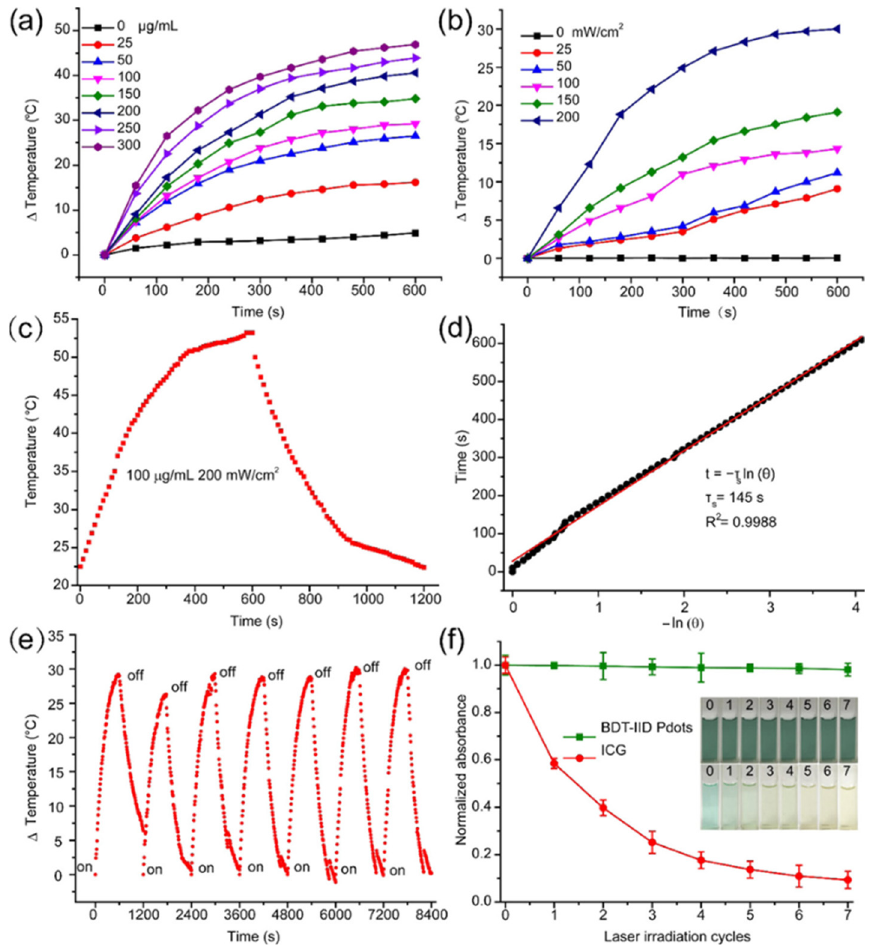
Figure 4. PTT characteristics of BDT-IID Pdots. PTT heating curves of the BDT-IID Pdots ( a ) with different concentrations upon 200 mW/cm 2 laser exposure at 660 nm and ( b ) with different laser power densities at 100 μ g/mL. ( c ) Photothermal effect of the BDT-IID Pdots dispersions under laser irradiation at 660 nm (200 mW/cm 2 ). Irradiation terminated after 600 s. ( d ) Time constant for heat transfer was determined to be τ s = 145 s by applying the linear time data from the cooling period (after 600 s) versus negative natural logarithm of driving force temperature, obtained from the cooling stage of ( c ); ( e ) thermal variations of the Pdots under laser exposure at 200 mW/cm 2 for seven light on/off cycles (10 min of irradiation for each cycle). ( f ) Change in absorbance intensity of BDT-IID Pdots and ICG after repeated laser irradiation ( n = 7). The figure inserts show the changes of BDT-IID Pdots and ICG after repeated laser irradiation ( n = 7). (Reprinted Permission American Chemical Society 2018) [49] .